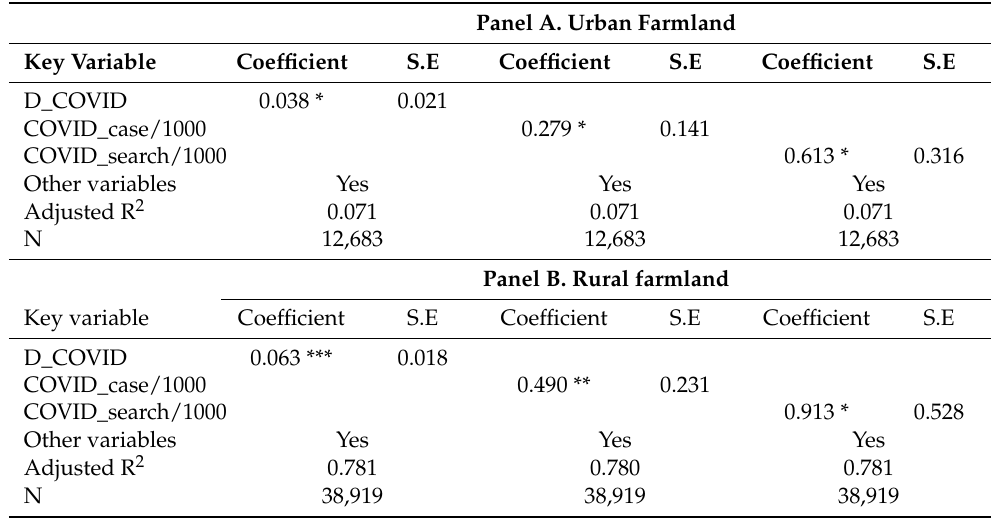
Table 4. Estimation of the farmland price equations.